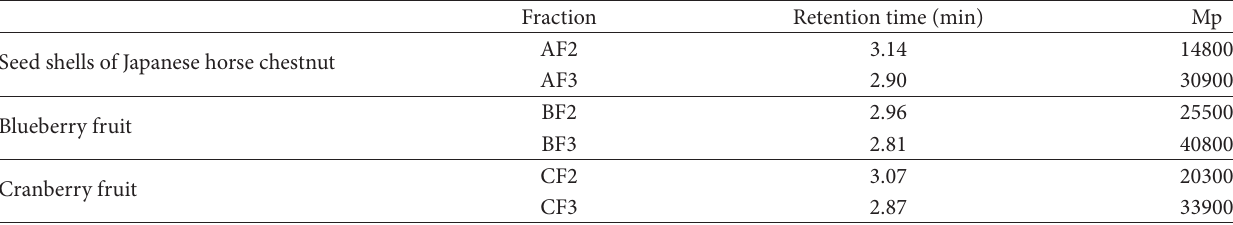
T 1: Molecular sizes of two different fractions of highly polymeric proanthocyanidins isolated individually from food sources of seed shells of Japanese horse chestnut, blueberry, and cranberry as determined by gel permeation